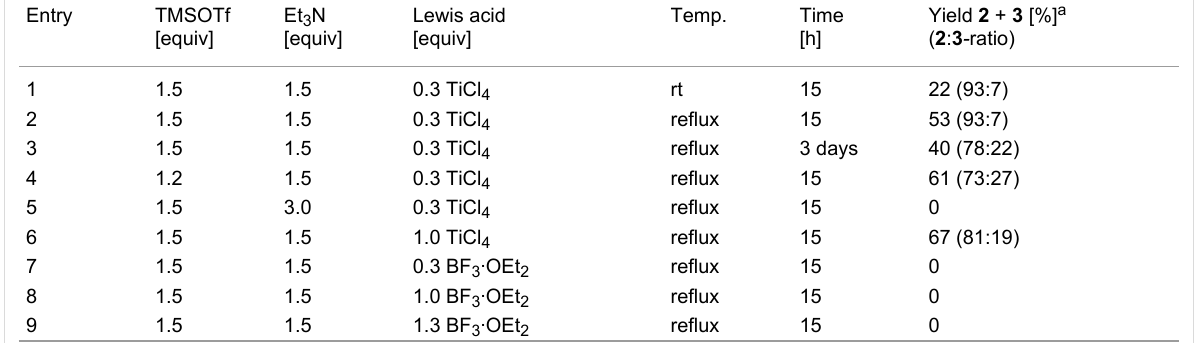
Table 1: Optimization of the reaction conditions for the silicon Mukaiyama-type aldol reaction of ester 1 with p -nitrobenzaldehyde.